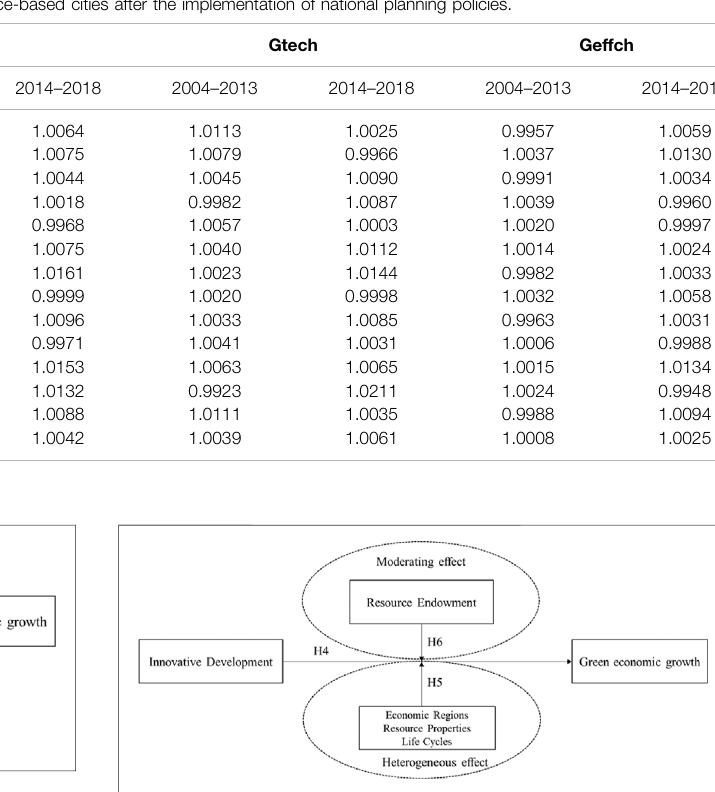
FIGURE 2 | Impact of innovative development on green economic growth of resource-based cities.